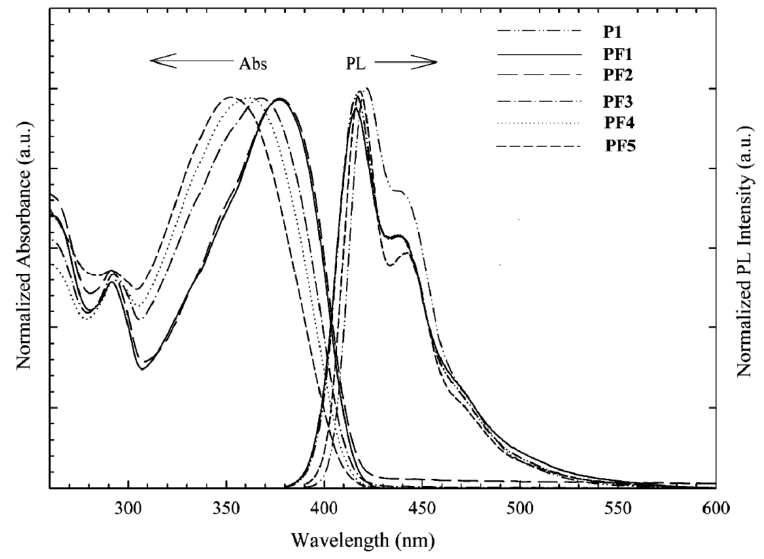
Figure 4. Photoluminescence and absorption spectra of HPFs in CHCl 3 . Reproduced from [78] with permission from the American Chemical Society.